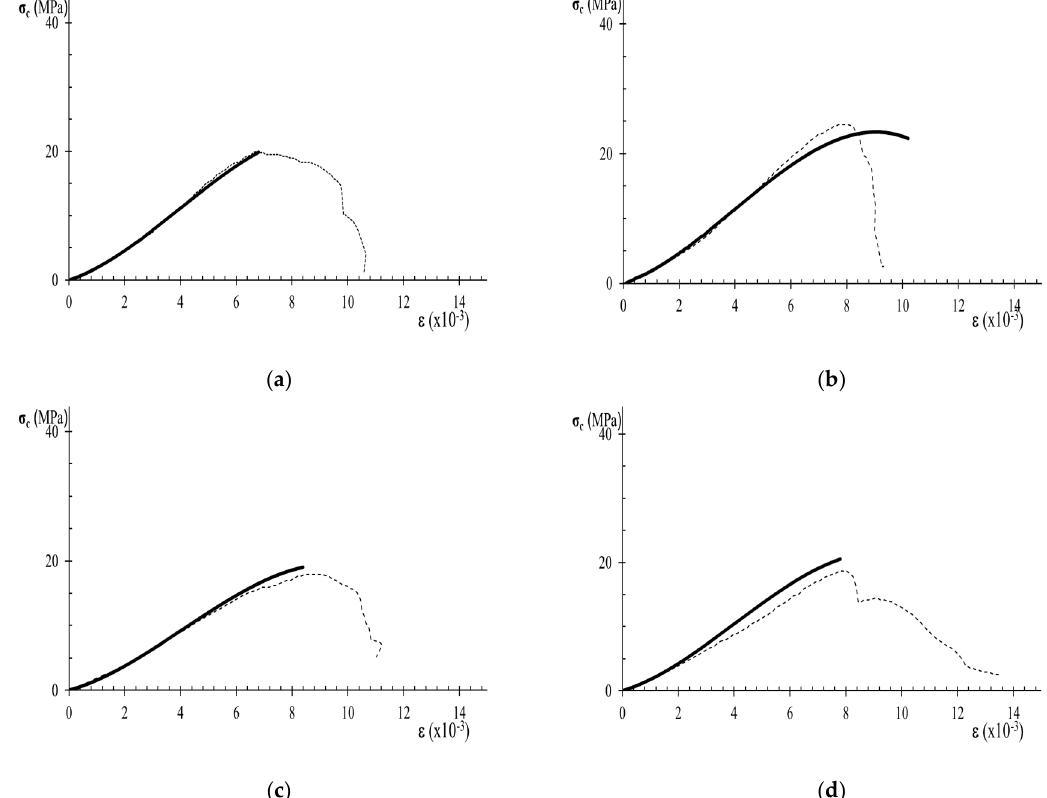
Figure 9. Analytical modeling of data from variety M sandstone specimens diagrams. The dashed black curves are the stress-strain diagrams of experimental results and the thicker black curves are the analytical stress–strain diagrams: ( a ) Specimen MP2; ( b ) Specimen MP3; ( c ) Specimen MP5; ( d ) Specimen MP1.